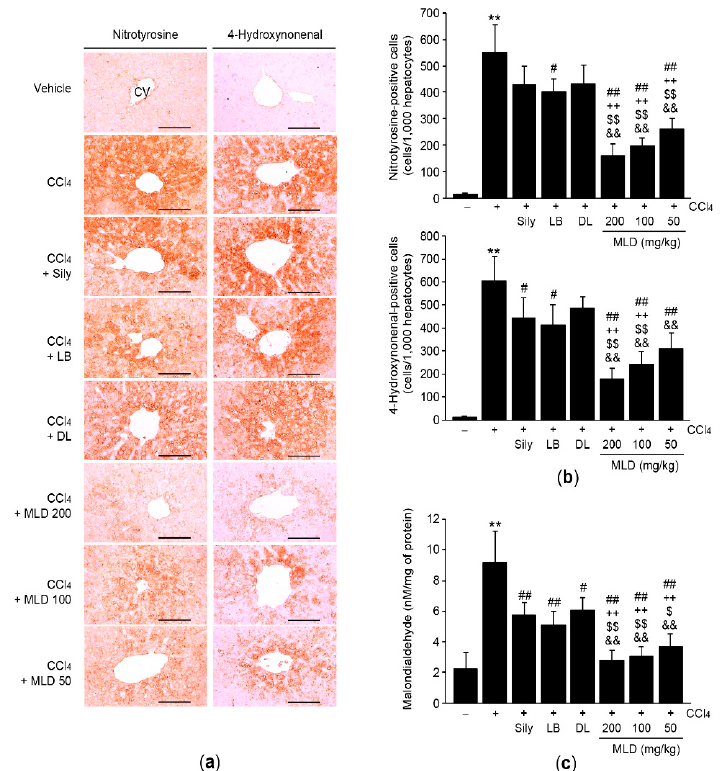
Figure 4. MLD alleviates CCl 4 -mediated oxidative stress. Hepatic tissues were immunostained using anti-nitrotyrosine or anti-4-hydroxynonenal antibodies ( a ), and positive cells were counted ( b ). Scale bars, 200 μ m. ( c ) Lipid peroxidation. Malondialdehyde concentration was determined using liver homogenates. All values are expressed as mean ± SD of ten mice. ** p < 0.01 between the vehicle and CCl 4 groups; ## p < 0.01, # p < 0.05 versus CCl 4 -injected mice; ++ p < 0.01 between Sily- and MLD-treated mice; $$ p < 0.01, $ p < 0.05 between LB- and MLD-treated mice; && p < 0.01 between DL- and MLD-treated mice. CV, central vein.